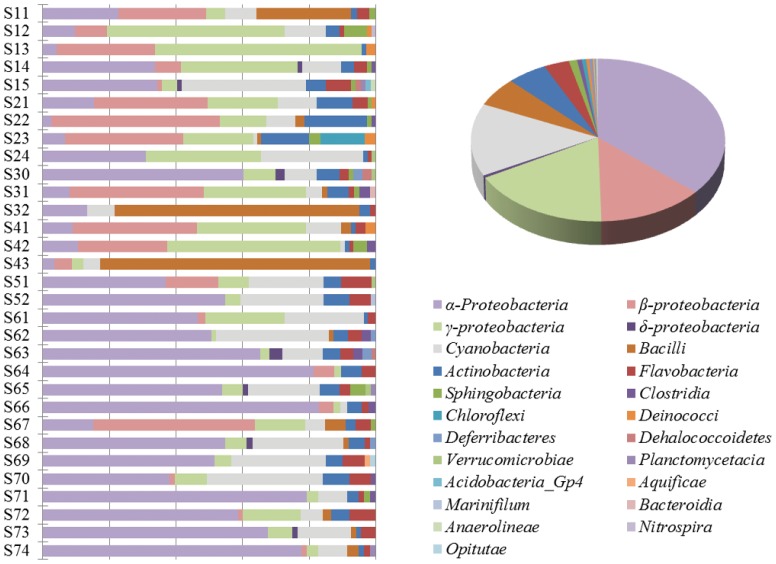
Phylotype distribution and comparison of the clone libraries from individual sampling sites (histogram) and entire nSCS (pie).